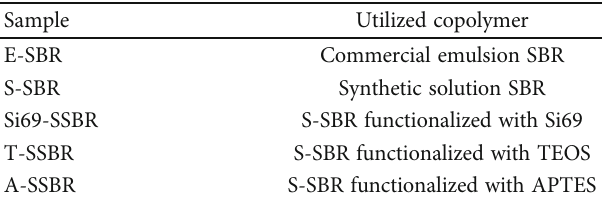
Table 3: The naming format of the prepared